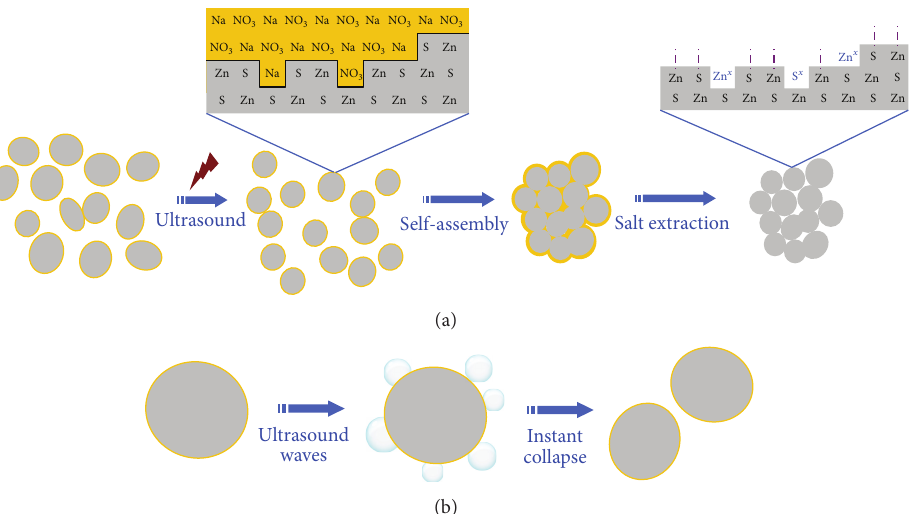
Figure 5: Formation mechanism of mesoporous ZnS nanomaterials (a) and simulated variation to a single nanoparticle during the period of ultrasound irradiation (b)